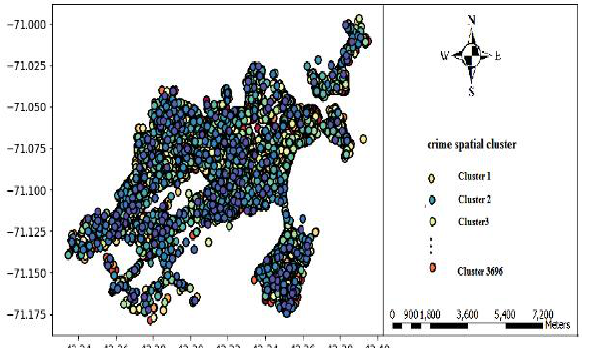
Figure 6. The result of crimes clusters by DBSCAN algorithm